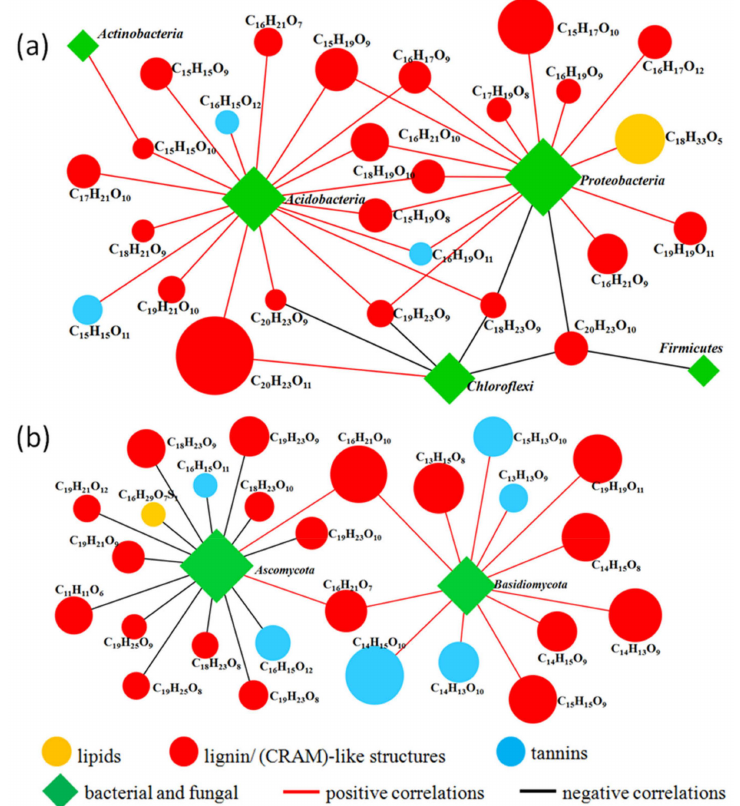
Figure 6. Interaction network analysis of the top 100 most abundant bacterial operational taxonomic units (OTUs) ( a ), top 50 most abundant fungal OTUs ( b ), and top 100 most abundant dissolved organic matter molecules in soil samples from the five sites of different forest types with significant correlations ( p < 0.01). Red circles are lignin/carboxylic rich alicyclic molecule (CRAM)-like structures, blue circles are tannins, and yellow circles are lipids; rhombuses are bacterial and fungal OTUs (green). Dissolved organic matter molecules’ relative abundances are proportional to node size. Red lines indicate positive correlations and black lines indicate negative